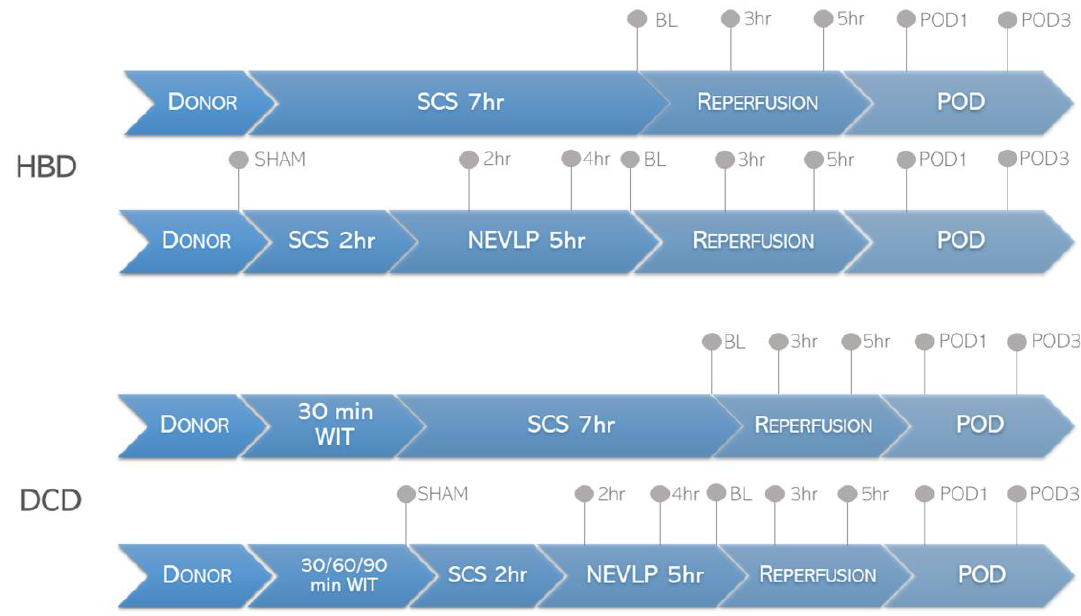
Figure 7. Experimental groups and design. Prior to procurement, animals were subjected to 0 min (HBD; heart beating donors), 30 min, 60 min and 90 min of warm ischemia to mimic donation-after cardiac death (DCD). Gray dots represent bile sampling time points. SHAM—prior to organ harvest; BL—baseline (start of reperfusion); WIT—warm ischemia